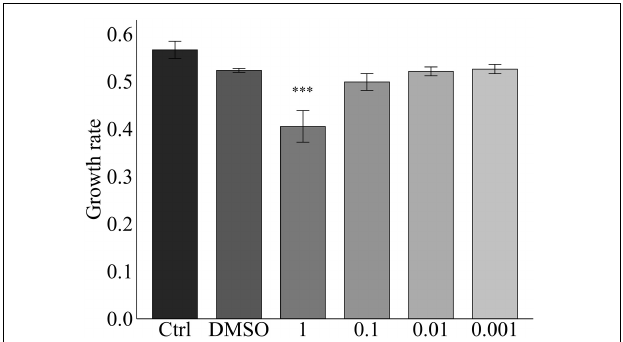
FIGURE 5 | Growth rates, m (d − 1), for the incubation with crude extract in the natural concentration (1), diluted 10x (0.1), diluted 100x (0.01) diluted 1000x (0.001). Error bars are standard errors. *Statistical significance compared to controls, p < 0.05. Asterisks represent significant p -values (alpha = 5%): p < 0.001 ∗∗∗ .